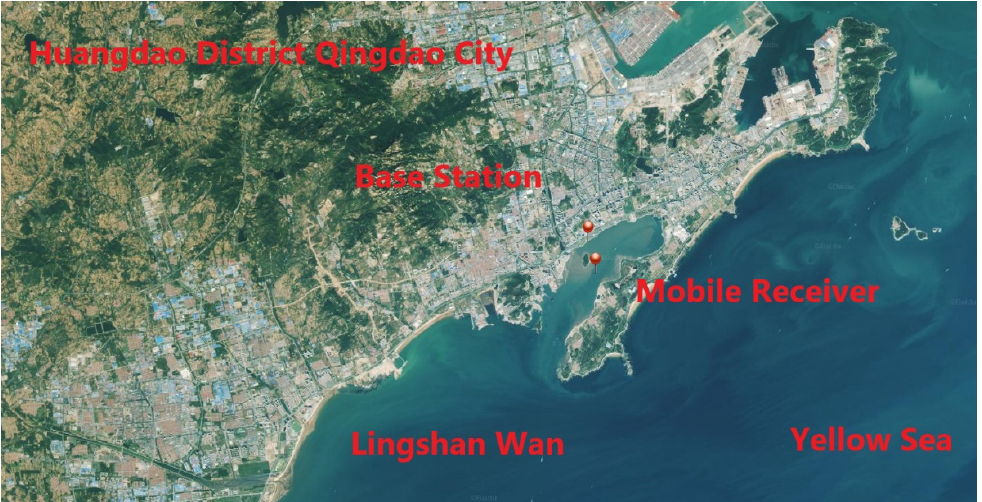
Figure 10. Positions of base station and mobile receiver for dynamic test carried on 23 September 2019 at 03:30 – 04:30 (GPS time).